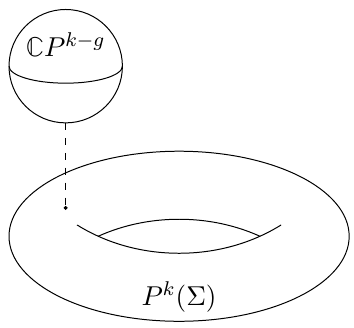
Figure 1. A sketch of the moduli space of charge k local Abelian vortices for k > 2 g − 2 . The moduli space fibres over the torus P k (Σ) , which is the moduli space of charge k holomorphic line bundles, with fibre C P k − g , which is the space of normalised sections. When k ≤ 2 g − 2 , there are degenerate fibres (see